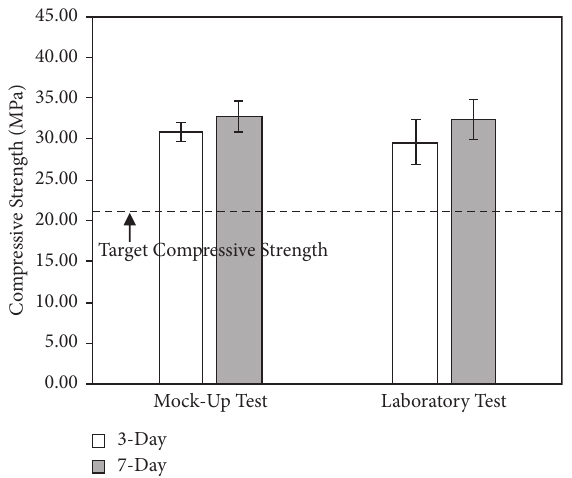
Figure 11: Comparison of compressive strength in mock-up and laboratory tests.